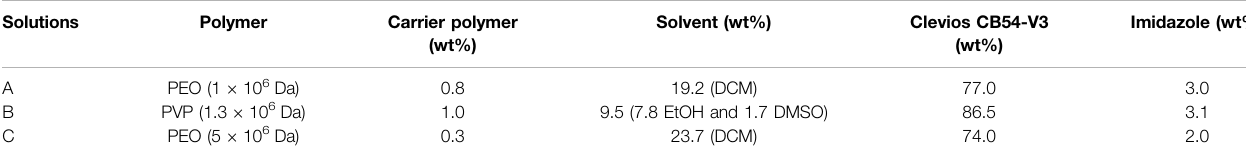
TABLE 1 | Composition of the electrospinning mixtures used to prepare fi brillar mats. Solutions